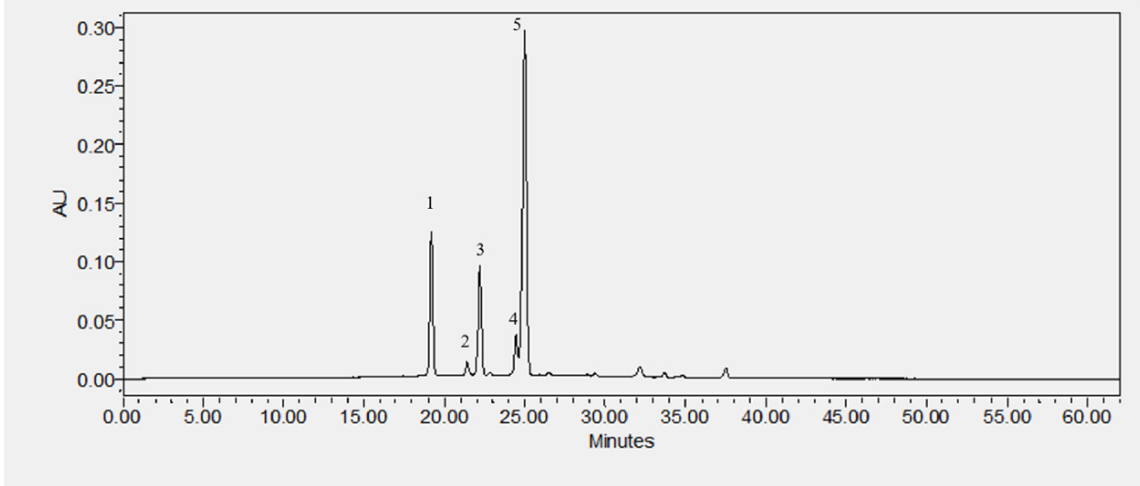
Figure 1. Total phenolic content of extracts performed with methanolic and aqueous solutions from grape wine-making by-products (gallic acid equivalent mg/g DW). OH—ohmic heating; CP—positive control; CN—negative control. Extraction solvents. ▪ MeOH with 1% HCl, ▪ H 2 O, ▪ lactic acid, ▪ citric acid. Different capital letters in the same extraction method indicate a statisti- cally significant difference ( p < 0.01). The small letters represent statistical differences between solvents and extraction methods ( p < 0.05).